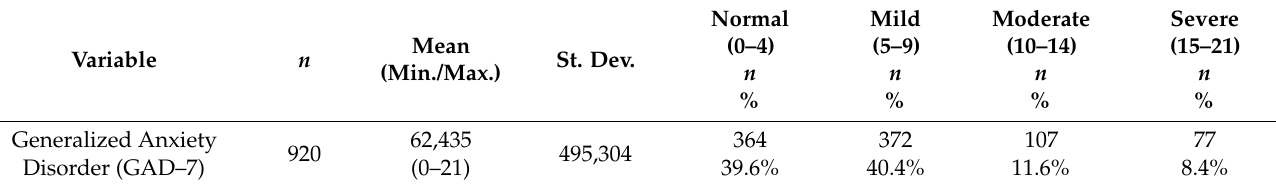
Table 2. Generalized anxiety disorder